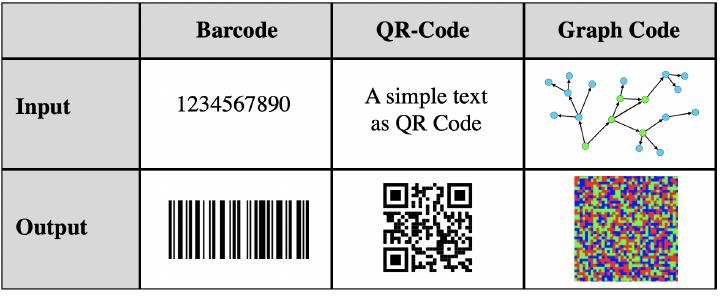
Figure 6. A visual comparison of barcodes, QR codes and graph codes.